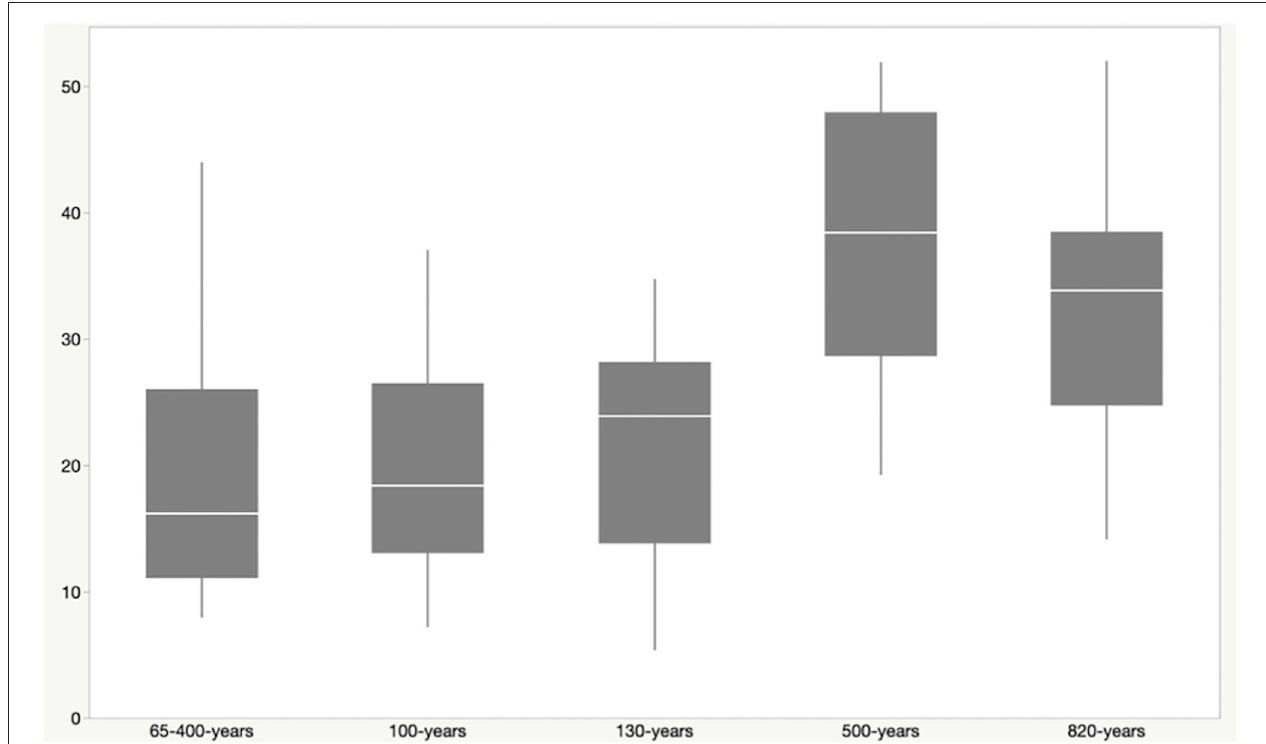
FIGURE 2 | Faith’s Phylogenetic Diversity (PD) vs. estimated site age. The approximate age of a particular site was defined by the latest flow recorded for the location. Steam vents (sites P & S) are features in two possible flow events and were thus given the range of 65–400 years, representing the earliest and latest potential time periods for those flows. Phylogenetic diversity increases with the increasing age of the lava flow at that site. PD was higher among sites that were 500–820 year old, when compared to younger sites. This includes Kaumana cave, a lava tube, which is only ∼ 130 years old.